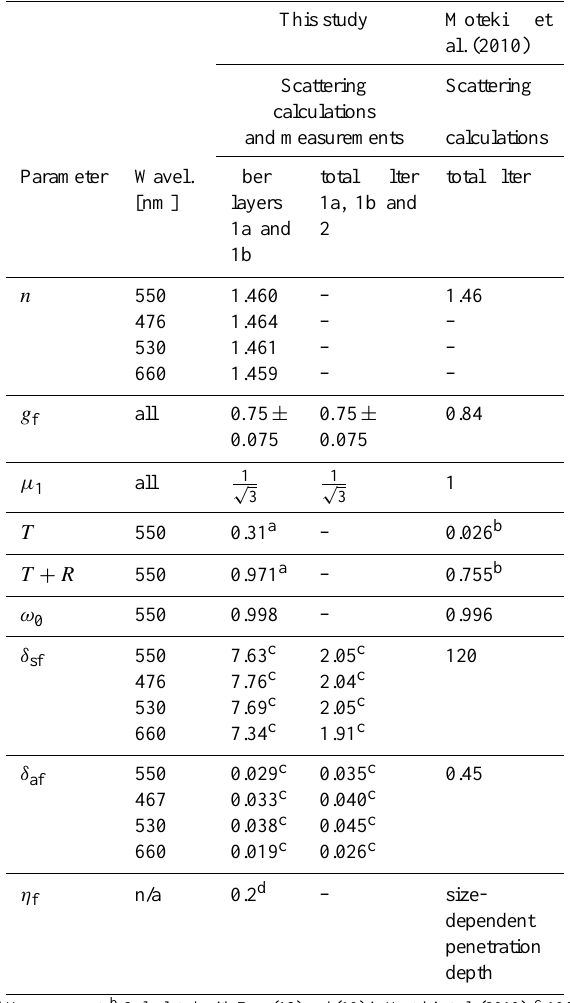
Table 1. Overview of parameters of fibrous filters. For comparison, values are given for wavelength 550nm and for the wavelengths of PSAP. This study Moteki